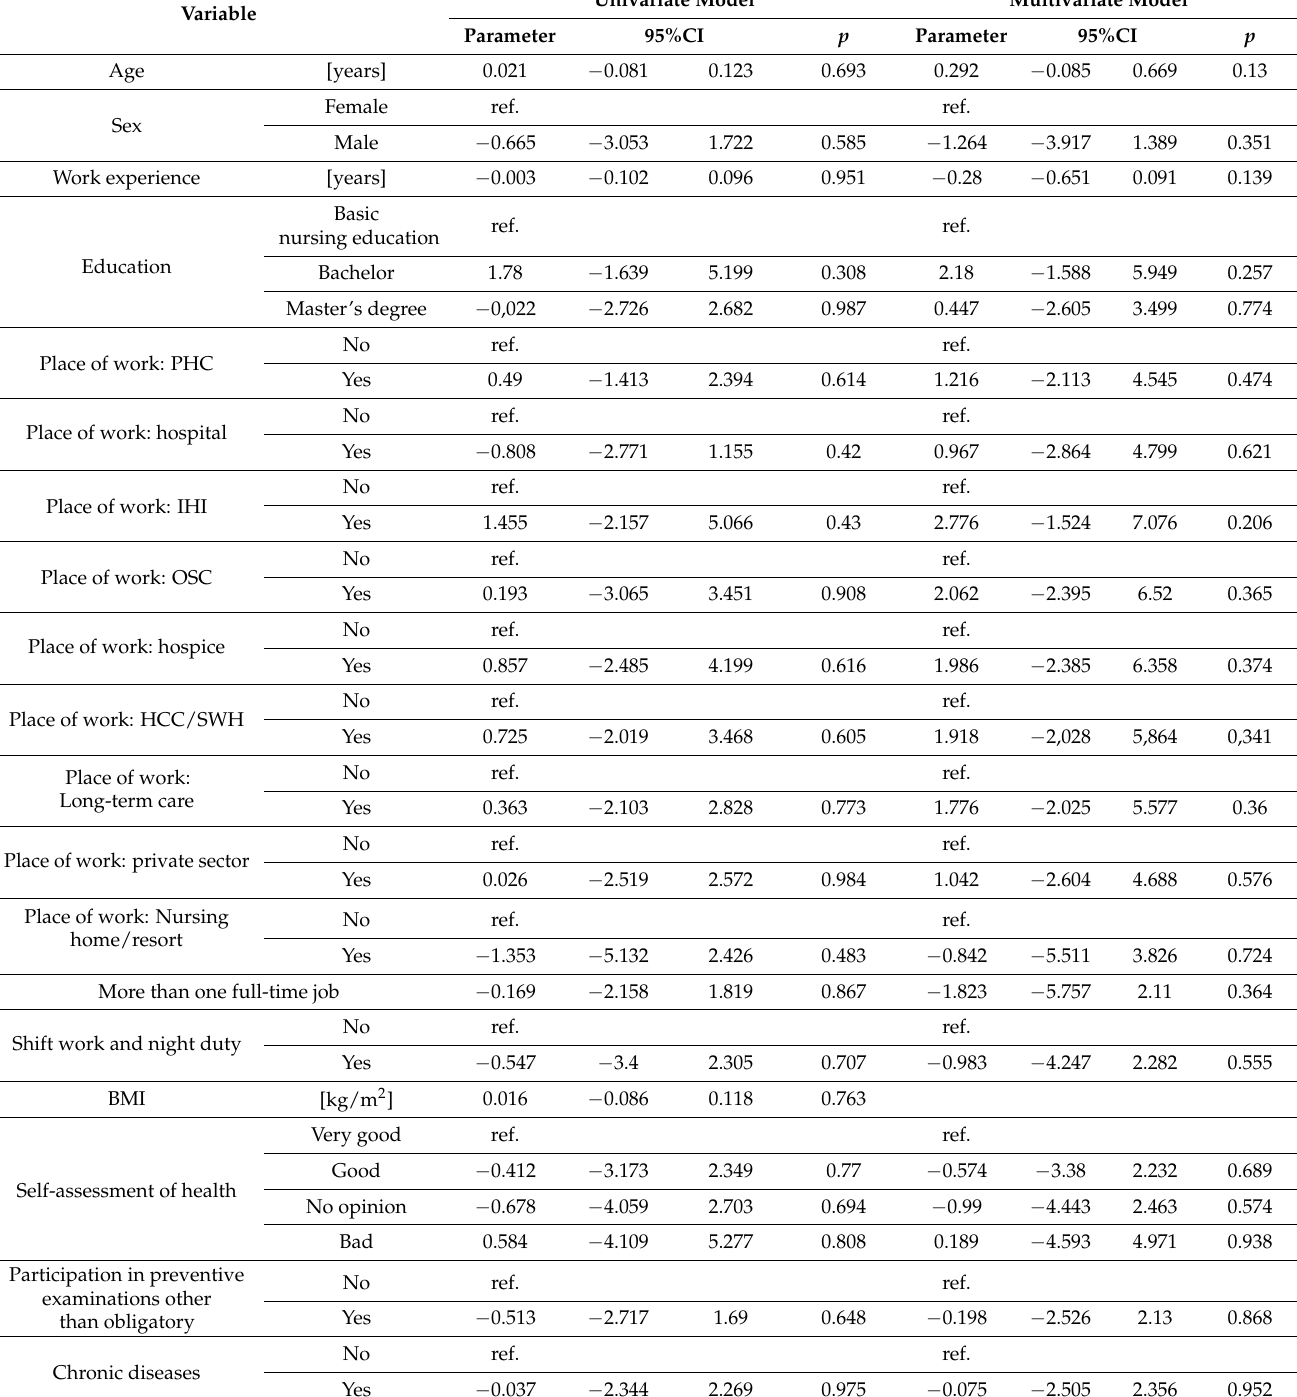
Table 5. Predicators of health behavior (HBI). Univariate and multivariate